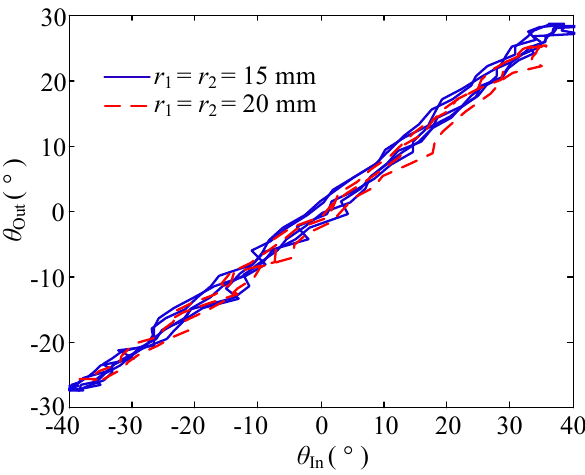
Figure 8. Displacement relationship when the radius of the pulley changes.